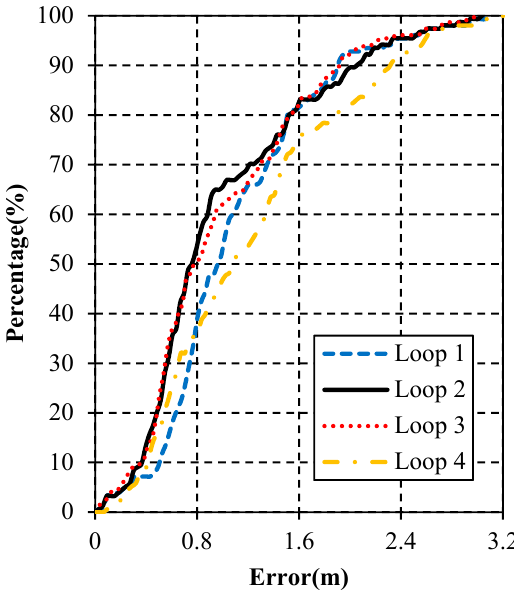
Figure 15. Cumulative error percentages in different loops.